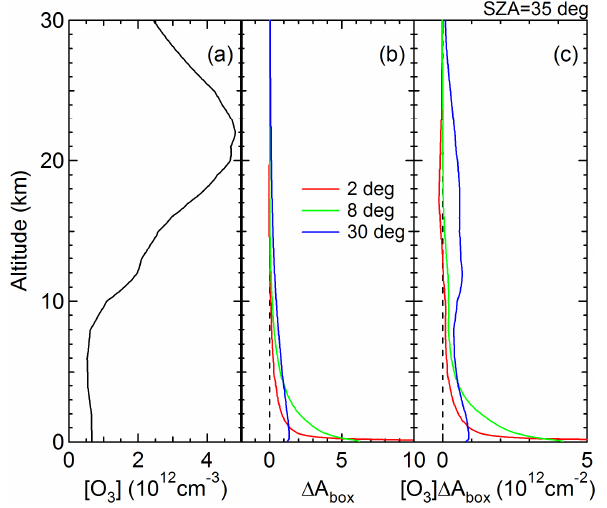
Fig. 3. Vertical profiles of (a) the number density of ozone ([O 3 ]) taken from the U. S. Standard Atmosphere, (b) the differential box air mass factor ( Δ A box ), and (c) [O 3 ] Δ A box at SZA = 75°. Red, green, and blue represent elevation angles of 2 ° , 8 ° , and 30 ° , respectively. Values are plotted for each 100 m. The relative viewing azimuth angle with respect to the Sun is assumed to be 180 ° .